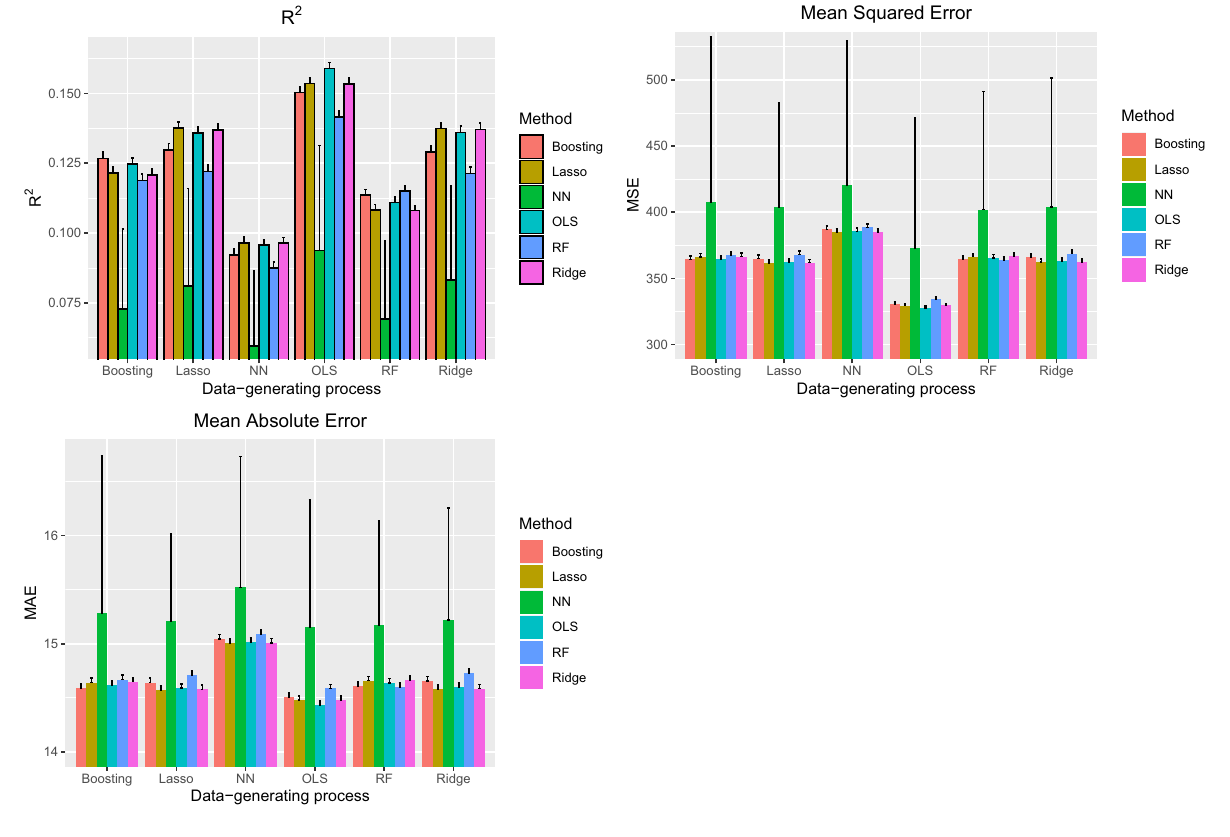
Figure 2. Performance in AMI sample (External